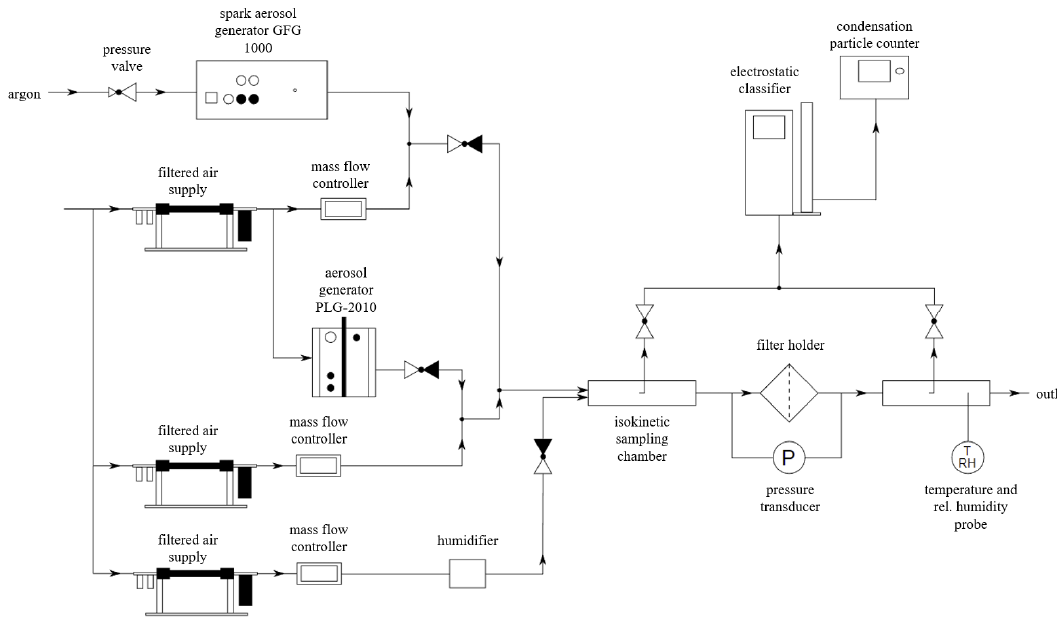
Figure 1. Experimental setup.